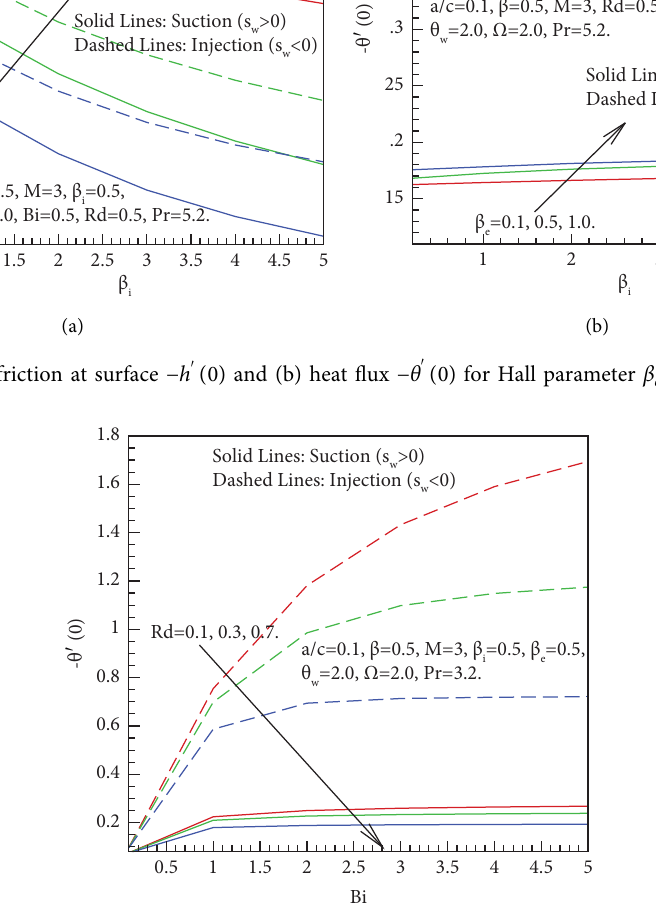
Figure 9: Heat fux − θ ′ ( 0 ) for radiation parameter Rd against number Bi .